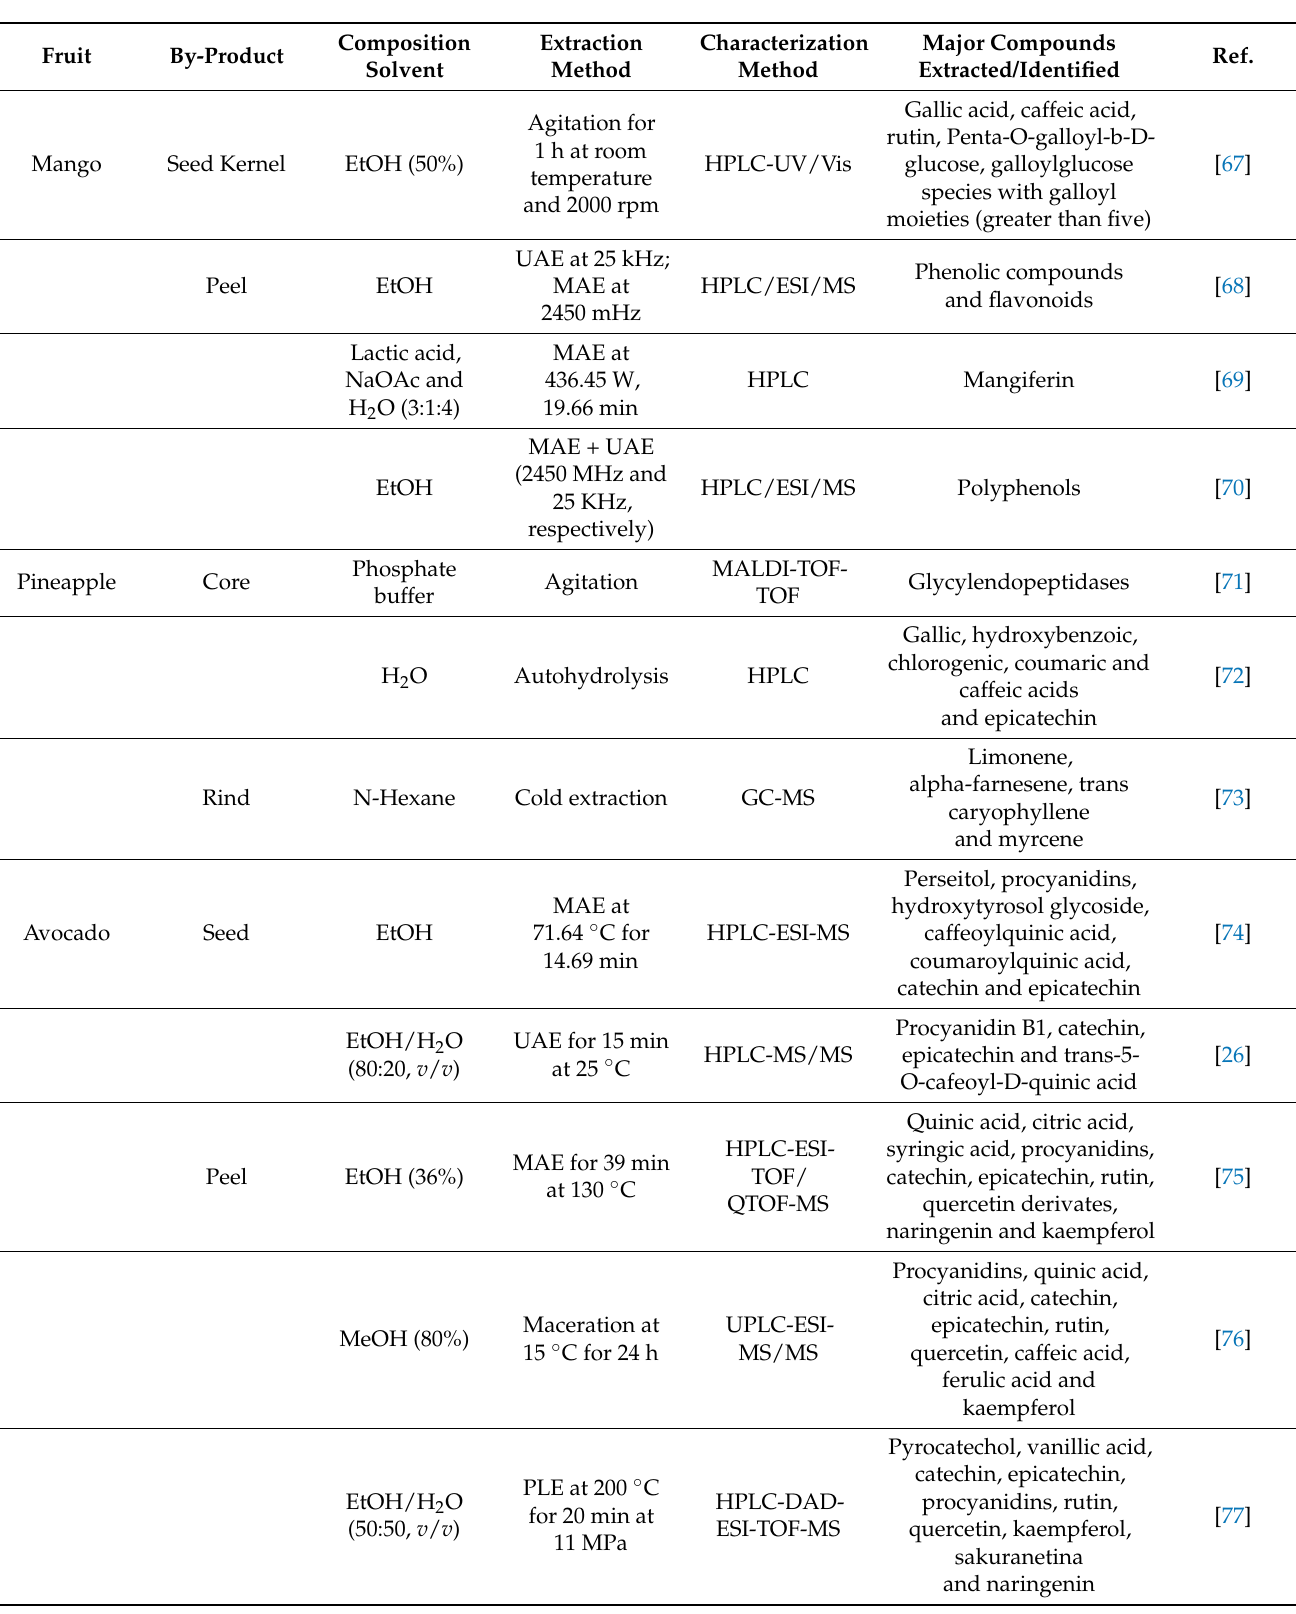
Table 1. Different green extraction used to obtain bioactives from tropical fruit